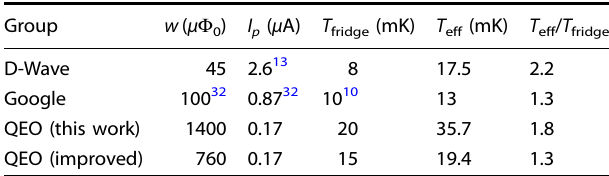
Table 1. Comparison of s-curve widths across experimental groups, where QEO stands for the quantum-enhanced optimization